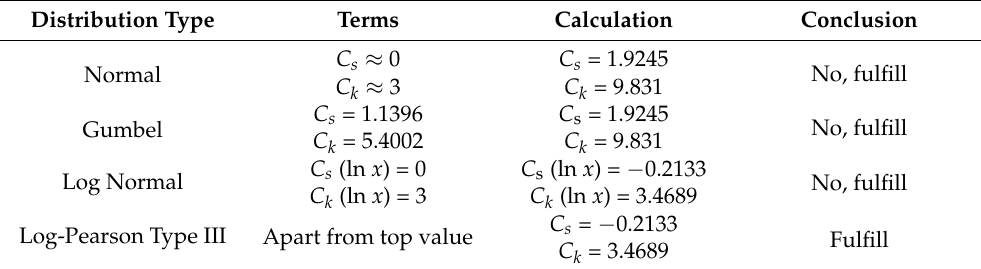
Table 2. Data Distribution of Requirements Testing for Using Frequency Analysis.